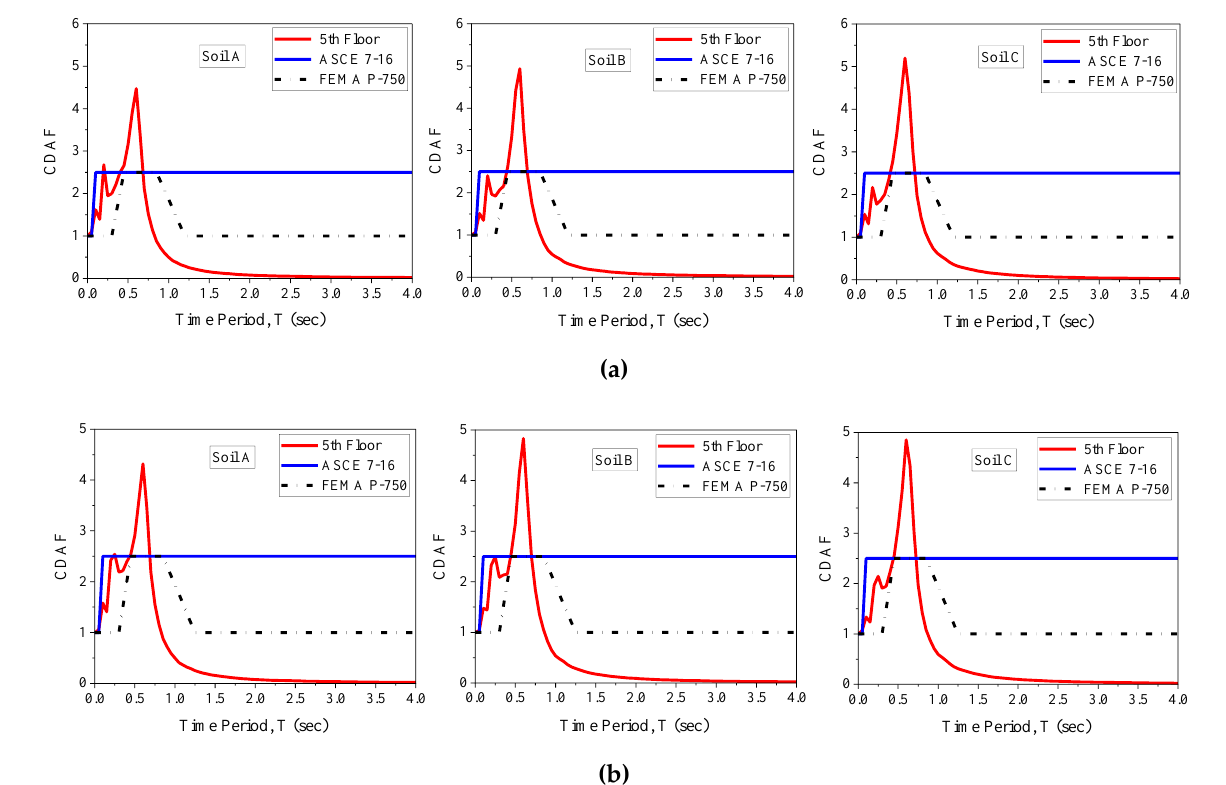
As a result, this study attempted to develop a CDAF spectrum prediction model using one of the machine learning techniques known as artificial neural networks (ANNs). Figure 13. CDAF for a top floor level ( a ) regular building; ( b ) irregular building. The effect of the damping ratio of NSC ( 𝜉 𝑁𝑆 ) on the seismic behavior of non-structural components must be assessed, as NSCs are characterized by different periods and damp- ing ratios [45]. Hence, in this particular study, component dynamic amplification factors are evaluated for different 𝜉 𝑁𝑆 (0.1%, 0.2%, 0.5%, 1%, 2%, 5%, 10%, and 20%). Figure 14 shows the top floor CDAF spectrum of regular and irregular building models for different NSC damping ratios (0.5%, 2%, and 10%). Lower 𝜉 𝑁𝑆 values resulted in higher amplifi- cation factor values, as expected. The effect of the damping ratio of NSC is found to be more significant at modal periods of the building models for all soil types. It is worth noting that the effect of 𝜉 𝑁𝑆 is insignificant over both very short and very long periods.